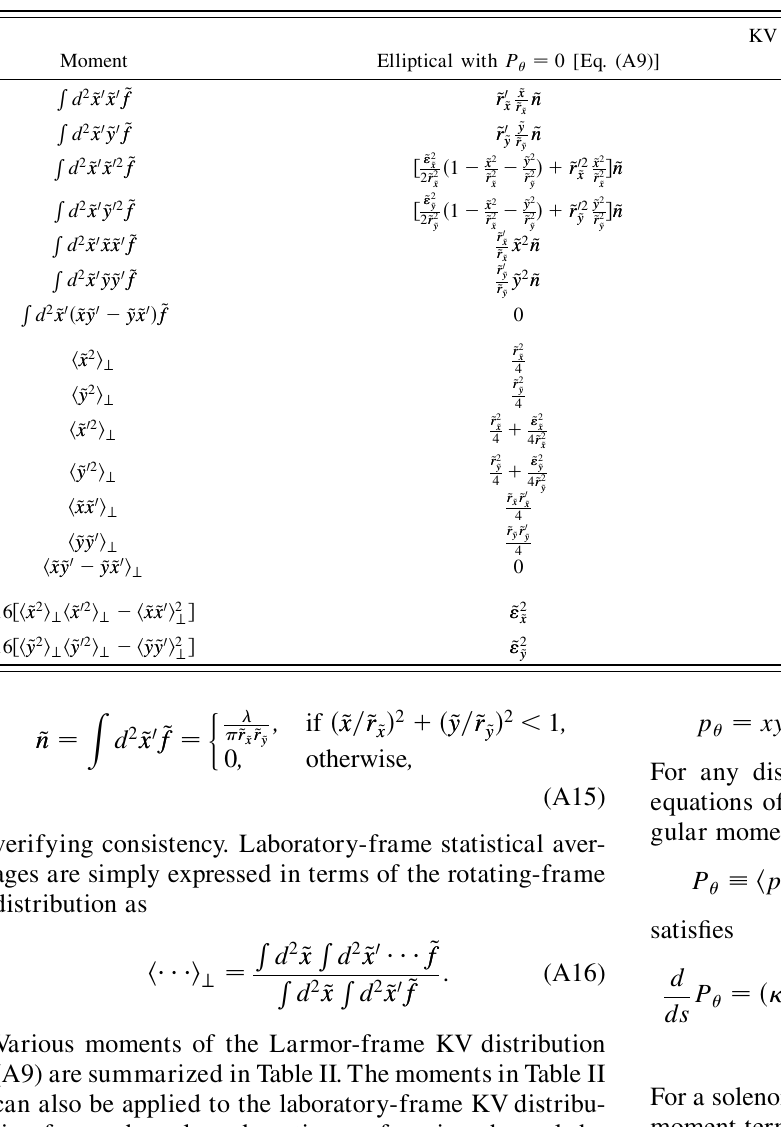
TABLE II. Moments of the KV distributions for an elliptical beam with P (cid:1) 0 and (cid:2) 1 < 2 P = ~ "" < 1 [Eq. (A21)]. All second-order moments not listed vanish (i.e., R d 2 ~ xx 0 ~ xx ~ yy ~ ff (cid:1) 0 , h ~ xx ~ yy i ? (cid:1) 0 ) for both P 4 4 distributions. Moment Elliptical with P 4 (cid:1) 0 [Eq. (A9)] Axisymmetric with P 4 (cid:1) 0 [Eq.